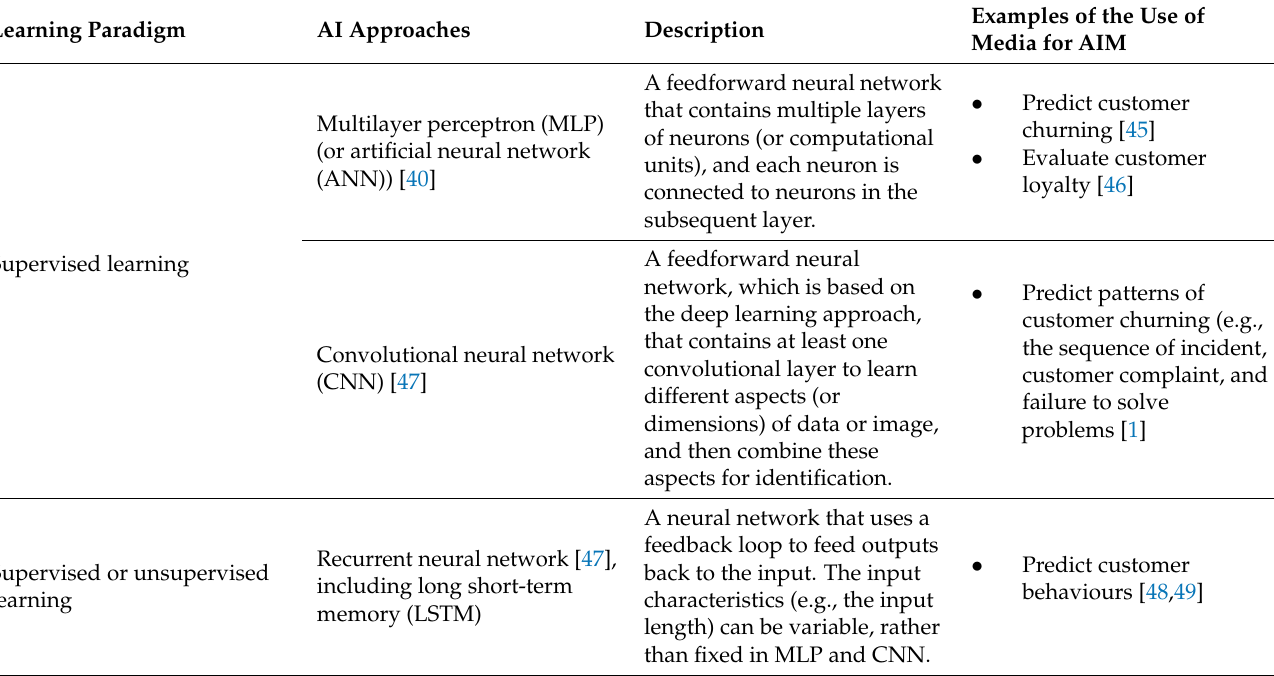
Table 3. Learning paradigms and their types of AI